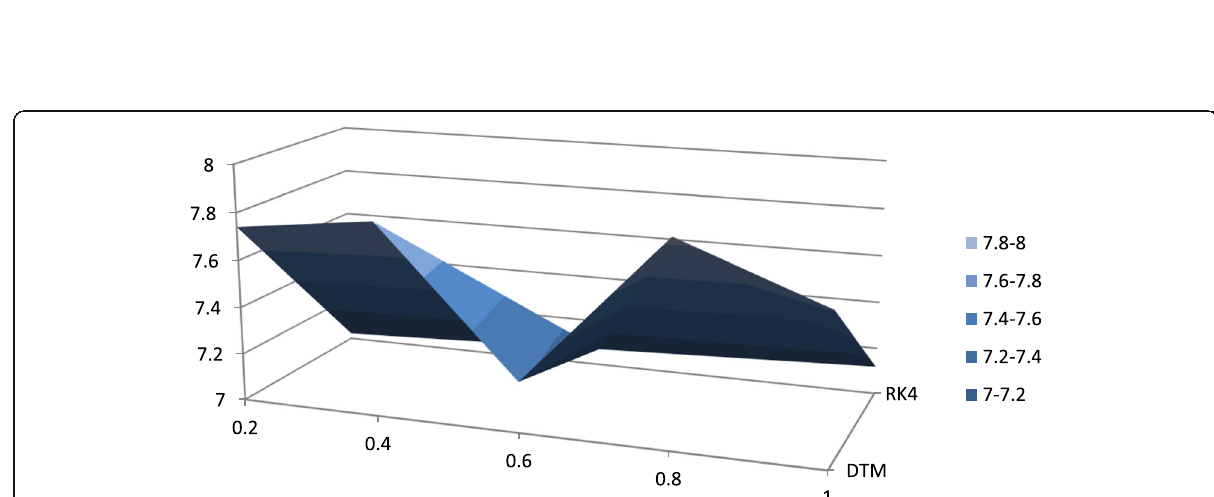
Fig. 16 Description of the behavior of the sub-population of infected individuals who did not attend or are non-compliant to medical awareness